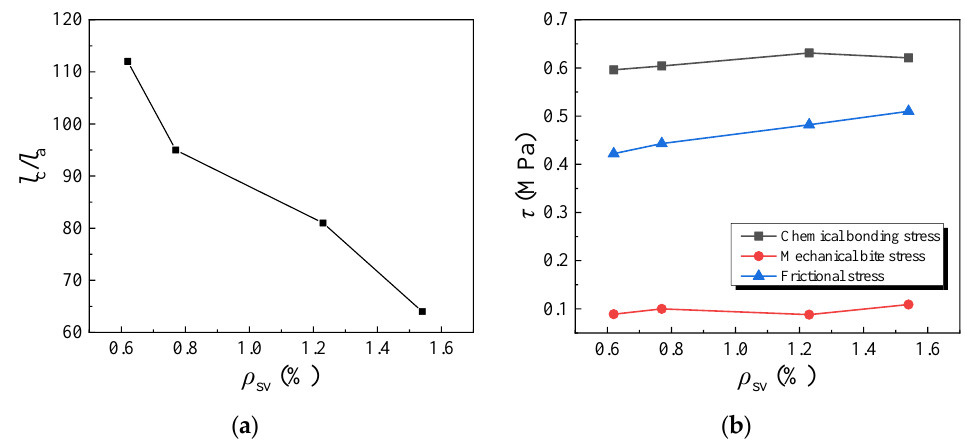
Figure 15. The effect of reinforcement ratio on the bonding capacity. ( a ) The effect of reinforcement ratio on l c / l a ; ( b ) the effect of reinforcement ratio on the bonding stress.